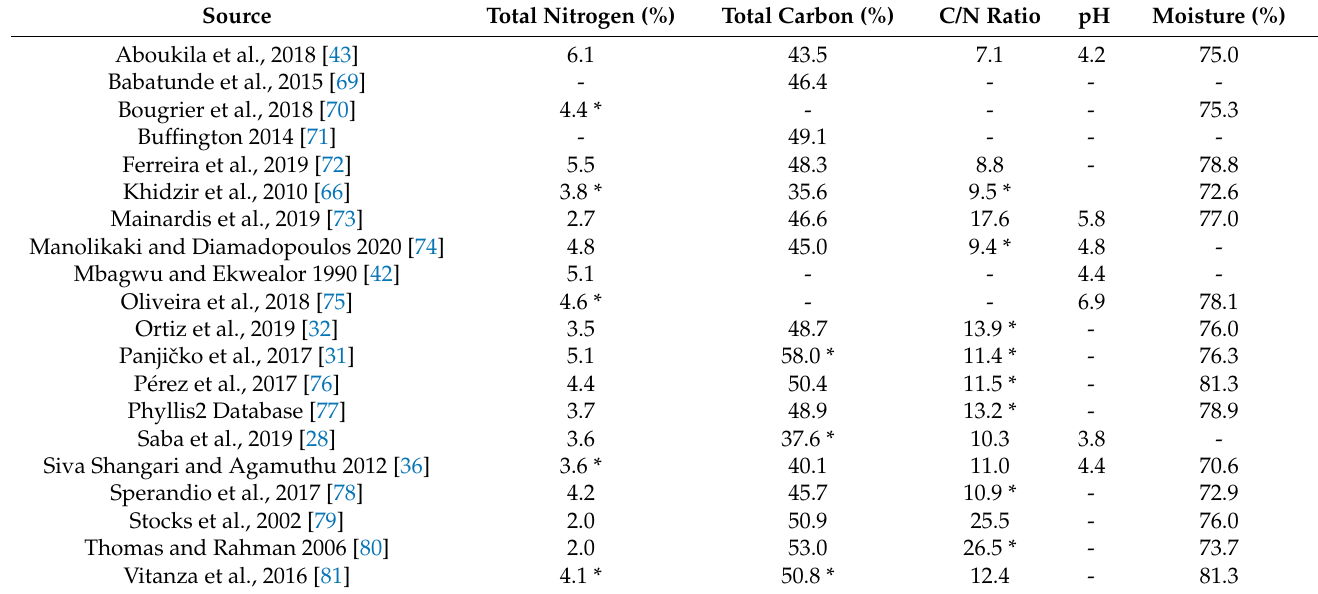
Table 1. Physicochemical characterization of brewers’ spent grain, expressed on a dry weight basis.